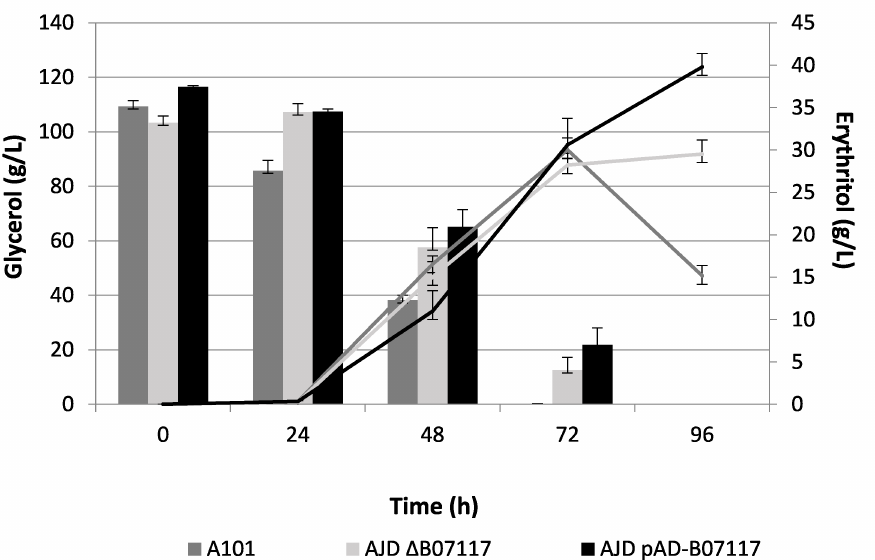
Figure 3. Glycerol utilization (bar chart) and erythritol production (line chart) by yeast strains A101 (gray), AJD ∆ B07117 (light gray) and AJD pAD-B07117 (black) in shake flask experiments using an erythritol synthesis medium. A standard deviation was added to the chart. Table 1. Erythritol and byproduct synthesis by the Y. lipolytica strains in shake flask experiments.